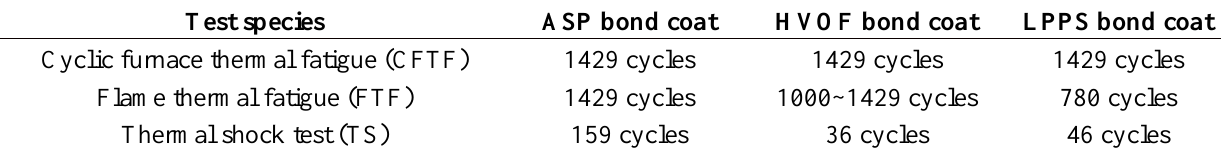
Table 1. The lifetime of thermal barrier coating (TBCs) with different bond coats after the thermal fatigue and thermal-shock